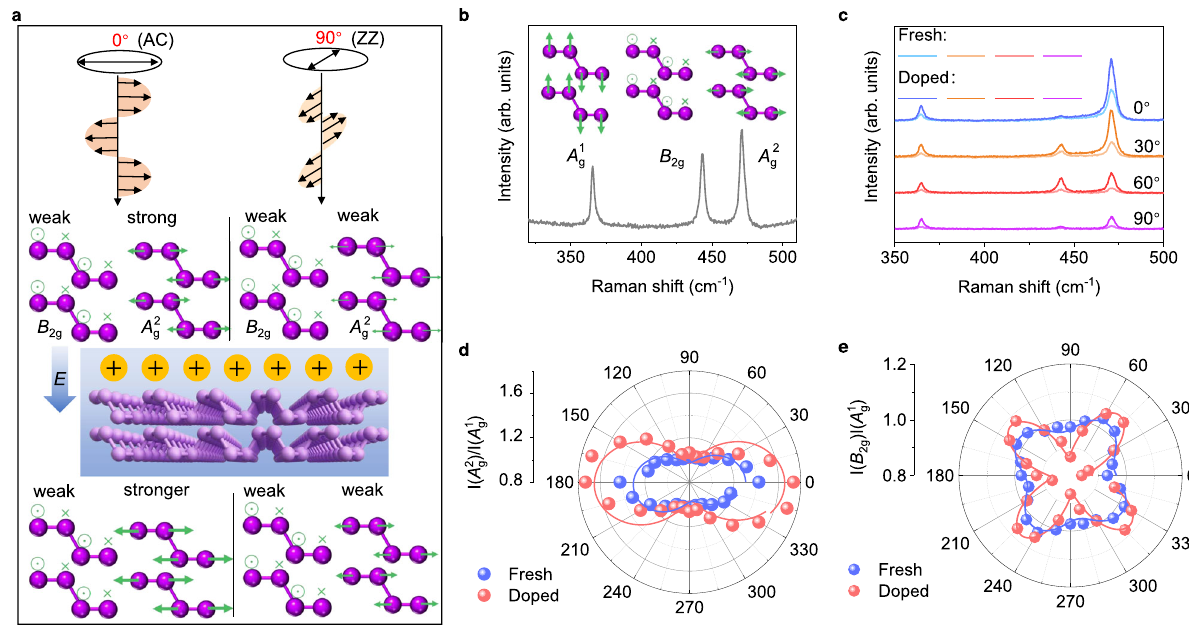
Fig. 2 Electrical tunable Raman scattering spectra of BP. a Schematic illustration of electrical tunable anisotropic Raman vibration modes in BP. The ferroelectric fi eld enhances the A g 2 vibration under 0° polarization light. The 0° (90°) light is linearly polarized along AC (ZZ) direction. The green arrows represent the vibration directions of raman modes. The E represents the direction of ferroelectric fi eld and the yellow spheres reprensent the p-type doping effect onBPby ferroelectric fi eld. b Typical measuredRaman spectrumof exfoliated BP fl ake.Theinsets illustratethreeRamanvibration modesofBP. c PolarizedRaman spectra of BP sample with different polarization angles (0°, 30°, 60°, 90°). d , e The measured (dots) and fi tted (line) angular-resolved Raman intensity ratio of the A g 2 / A g 1 mode and B 2g / A g 1 mode. The solid lines are fi tted using the function of I ( A g ) = (acos 2 θ + csin 2 θ ) 2 and I ( B 2g ) = e 2 sin 2 2 θ , where a , c , and e represent the magnitude of three independent components of Raman tensor, θ is the angle between the incident polarization and the AC